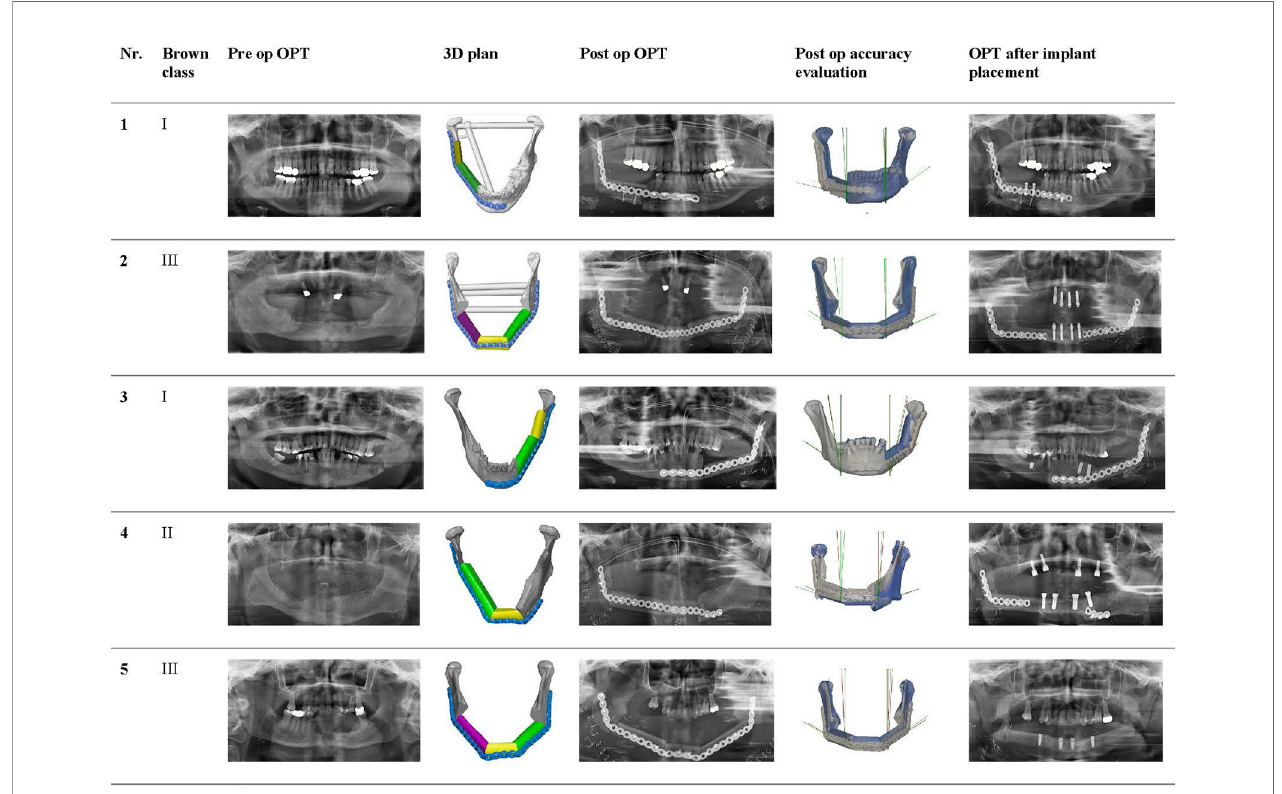
FIGURE 7 | Panoramic radiographs of all included cases preoperatively, postoperatively, and after implant placement, with the 3D plan and accuracy measurements added in